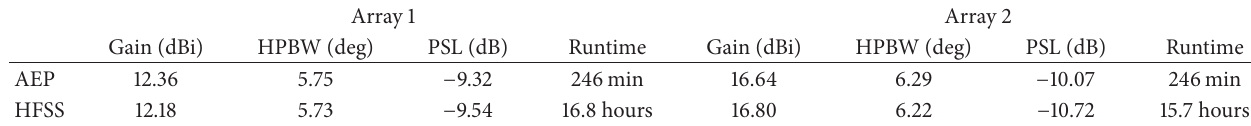
Table 3: Gain pattern performance of conformal thinned arrays.